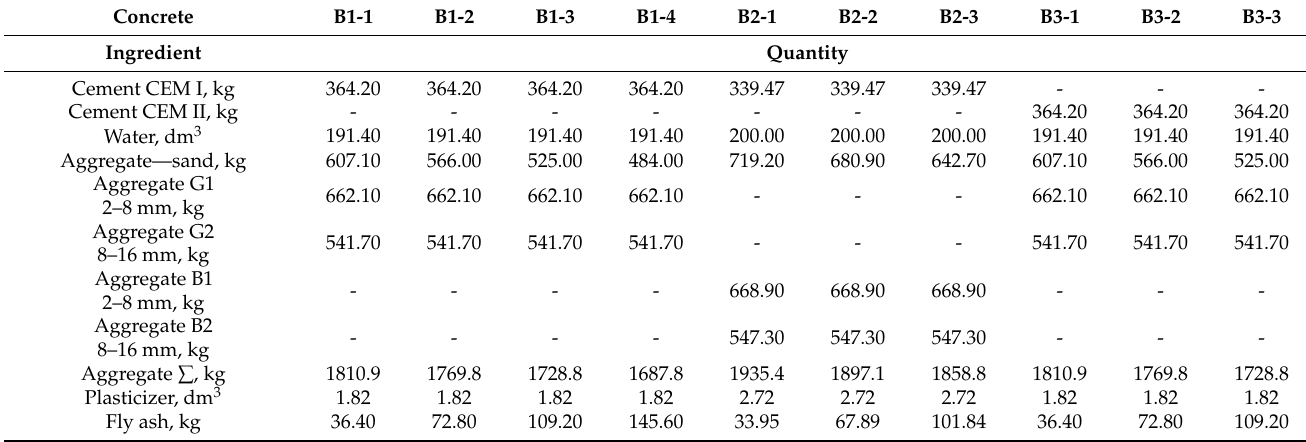
Table 3. The composition of concretes with the addition of ash B1, B2 and B3